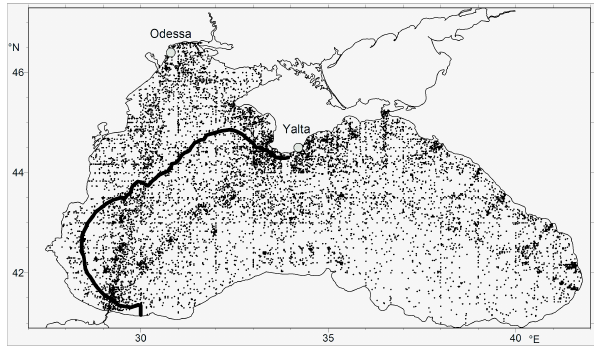
Fig. 1. Spatial distribution of the original measurements is shown. The solid line separates the western shelf (WS) and the deep sea (DS). Open circles indicate locations of the weather stations Odessa and